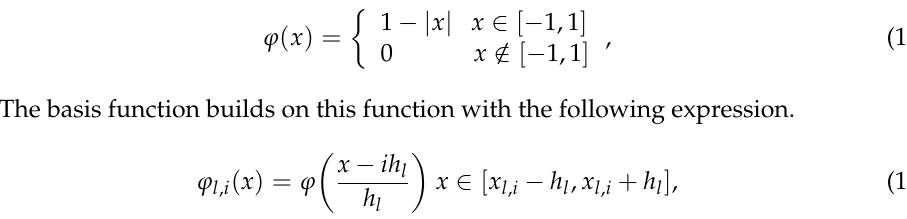
Table 3. The range of values of structural parameters.